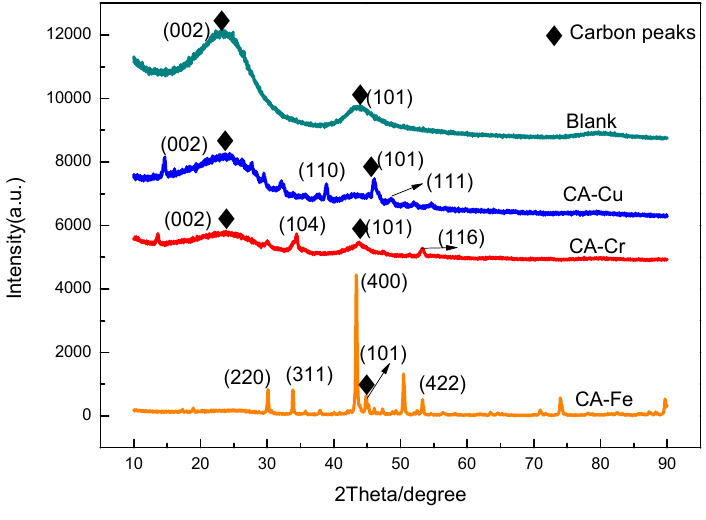
Figure 8. XRD patterns of CA-X.